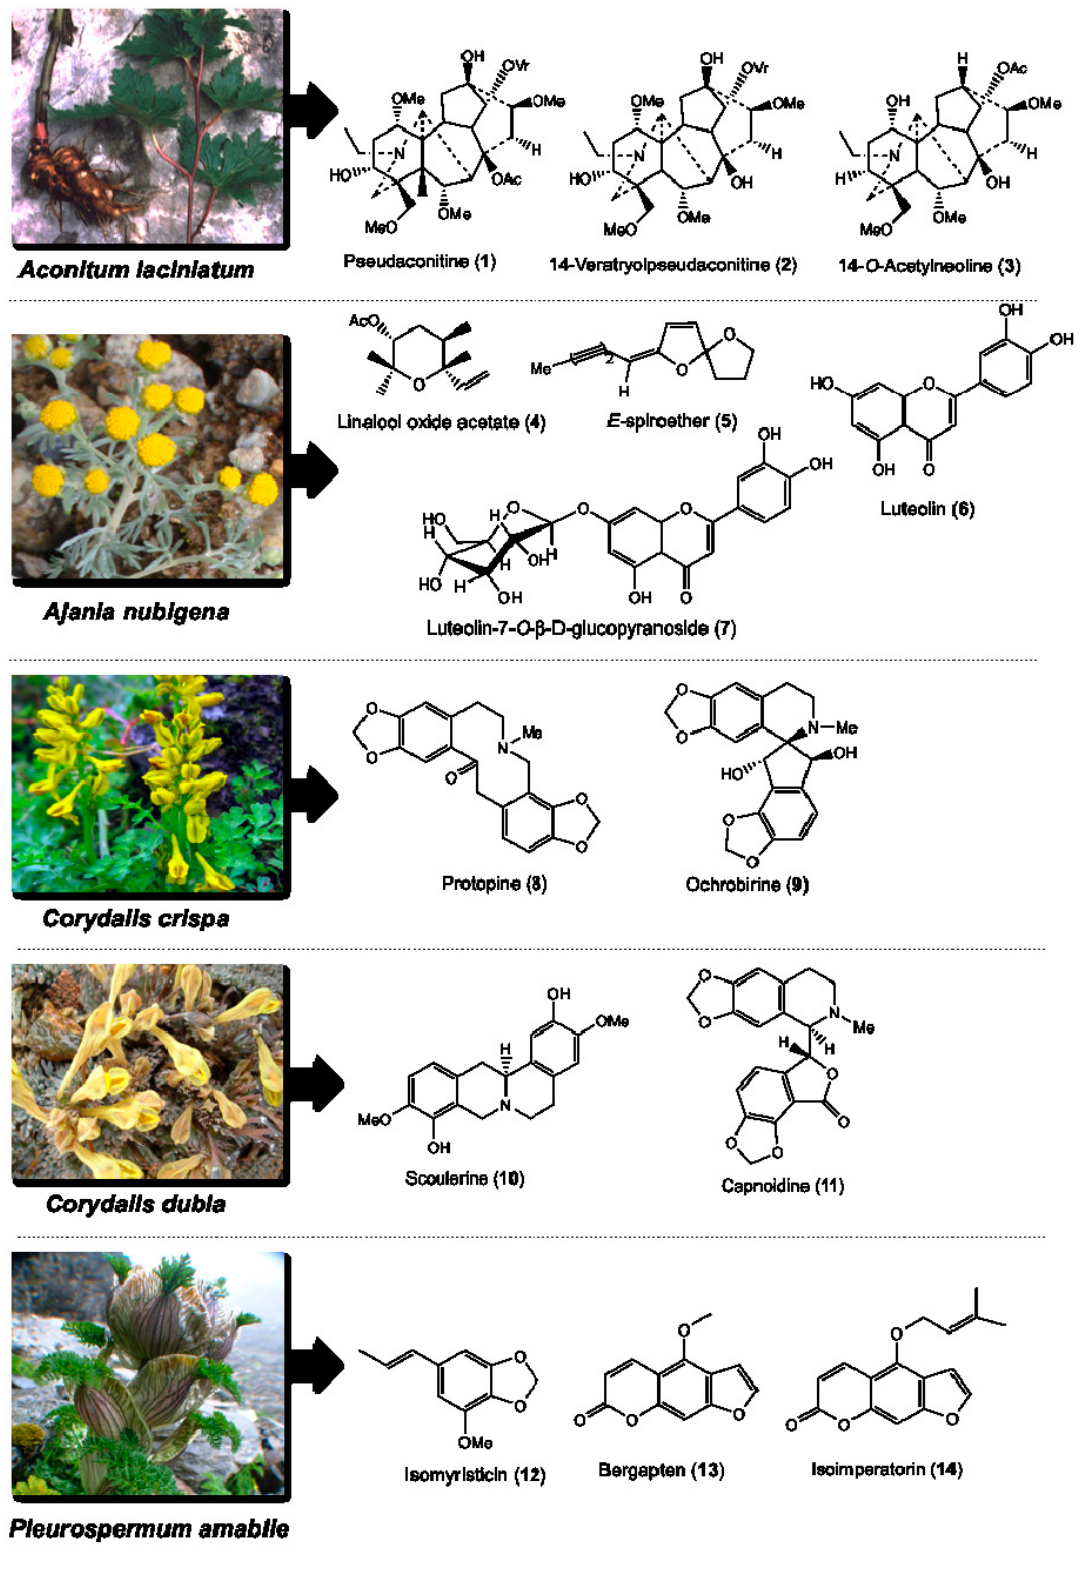
Figure 1. Structures of the compounds isolated from five Bhutanese medicinal plants using methods described by us previously [31–35], which were tested for their immunomodulatory and cytotoxic activities. Representative plant photos of Aconitum laciniatum, Ajania nubigena , Corydalis crispa , C. dubia , and Pleurospermum amabile are shown.